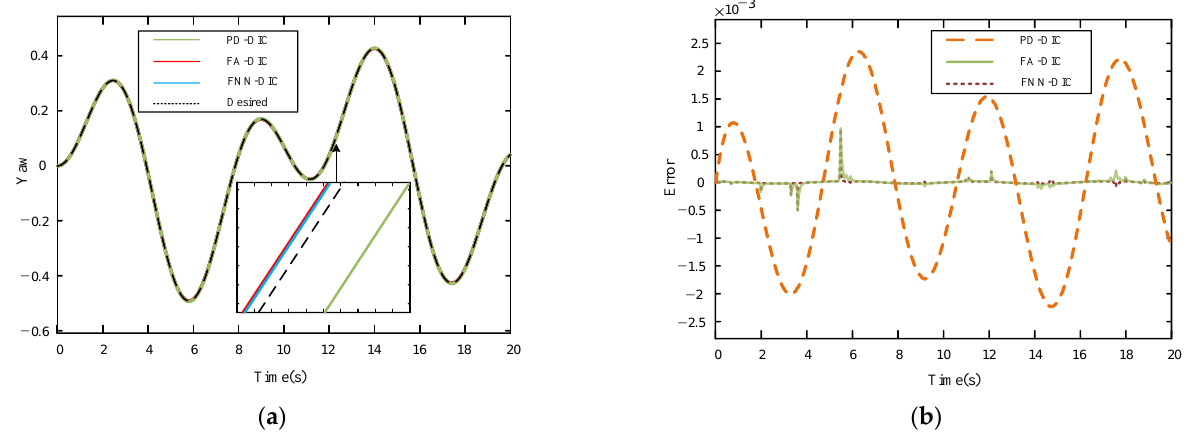
Figure 10. The results of the yaw angle trajectory tracking. ( a ) Yaw angle tracking track, and ( b ) yaw angle tracking error.